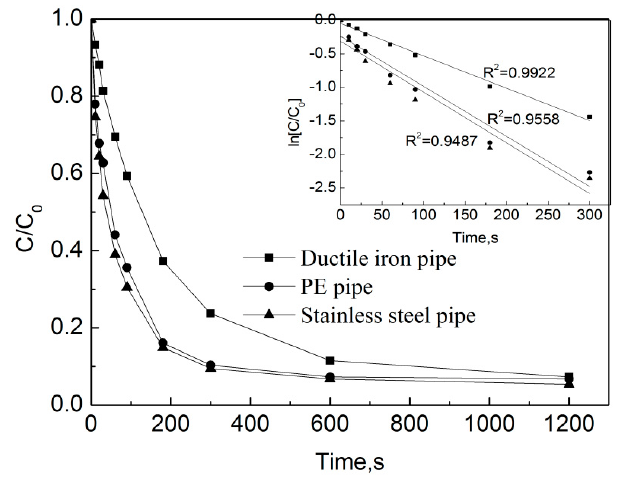
Figure 7. Degradation of OFL under di ff erent pipe materials in the water distribution